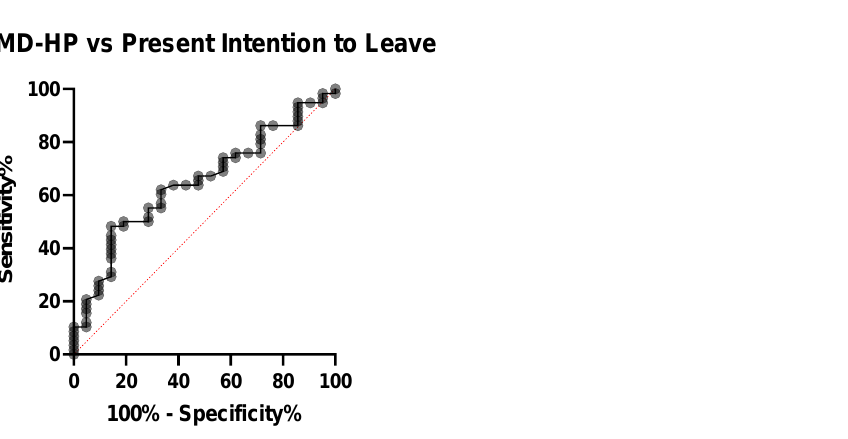
Figure 3. ROC curve of MMD-HP score versus present an intention to leave the current workplace in the ICU.